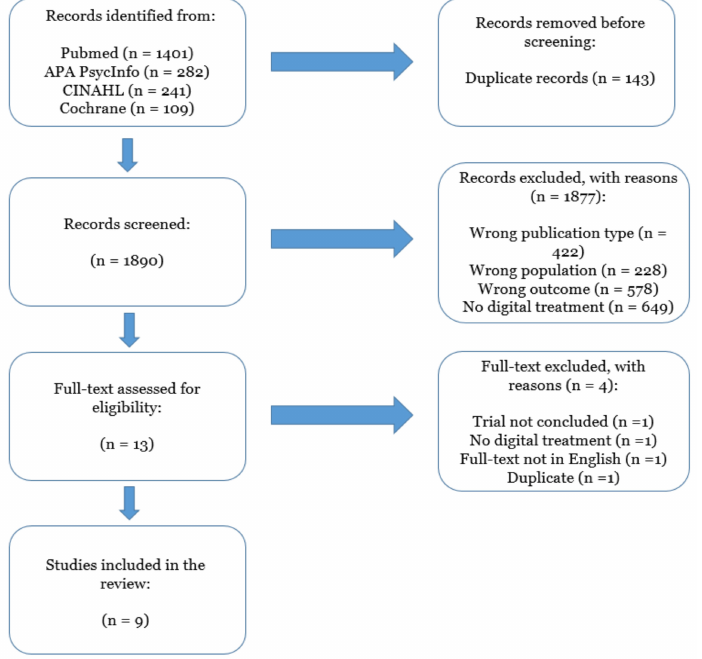
Figure 1. PRISMA flow chart describing the inclusion process of the